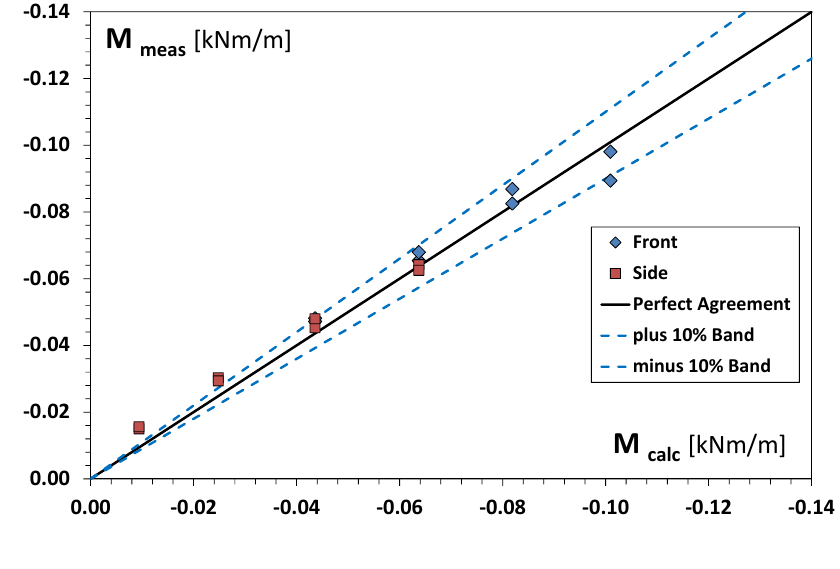
Figure 25. Measured vs. predicted wave overturning moments (short crested